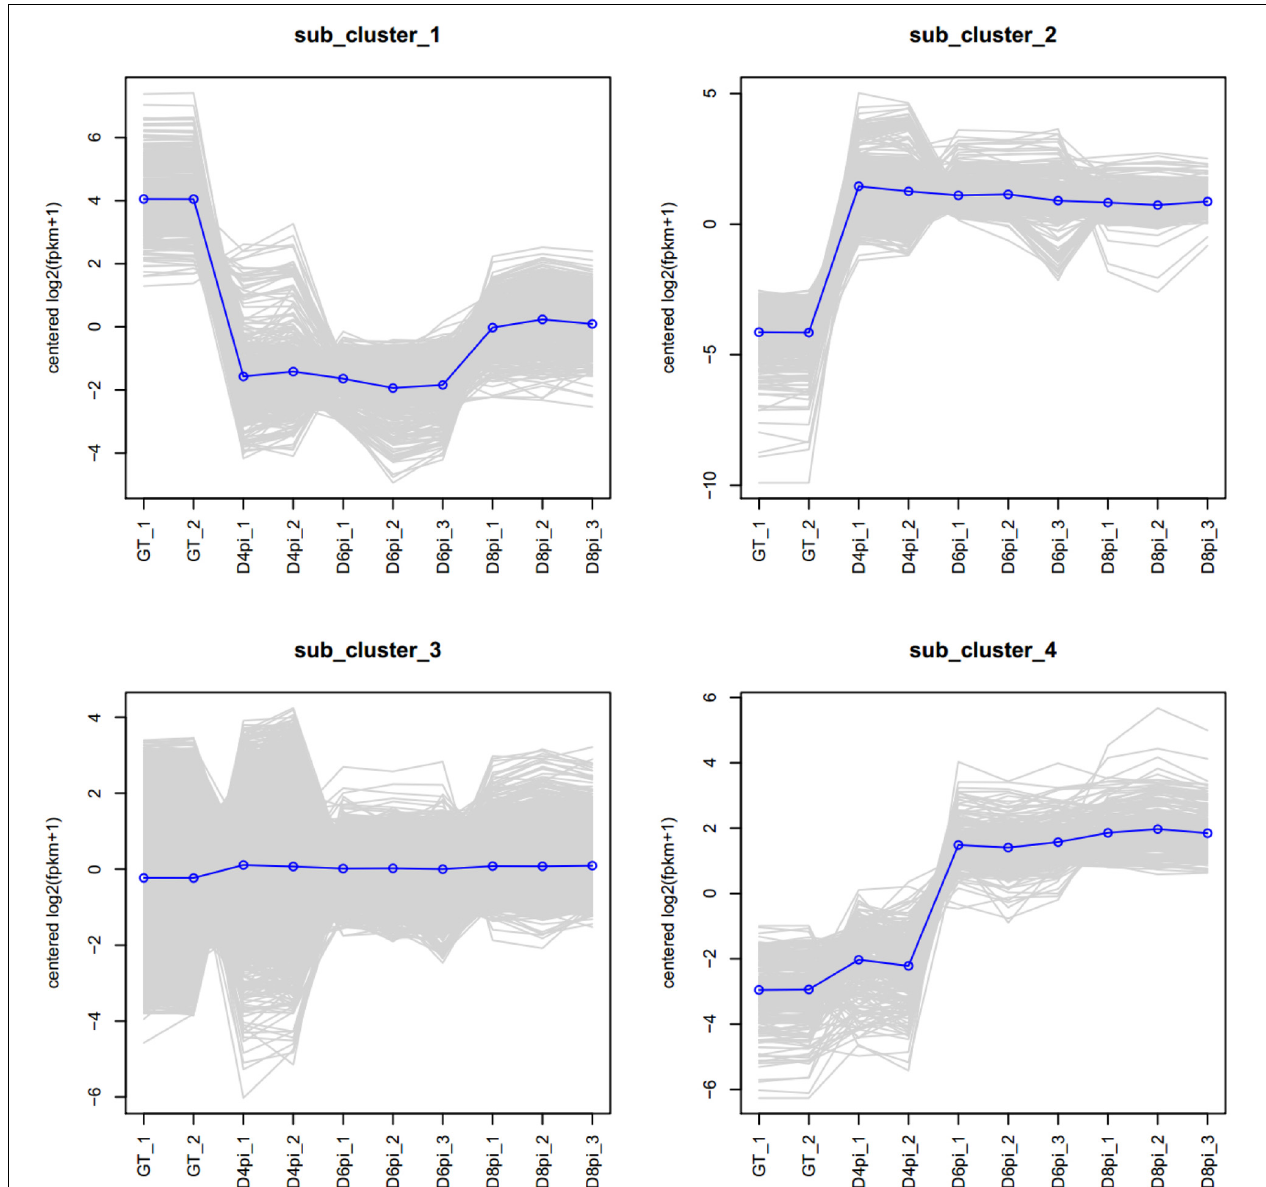
FIGURE 1 | Clusters of Pt genes based on gene expression patterns. A total of 17,976 genes, including 2,284 “novel” transcripts, were annotated in the transcriptome. Four sub-clusters of genes were classified based on the observed expression patterns during rust infection. The sub-clusters are genes highly expressed in germ tubes (GT, sub_cluster_1), genes induced upon infection (sub_cluster_2), genes not induced (sub_cluster_3), and genes induced at late stage of rust infection (sub_cluster_4).